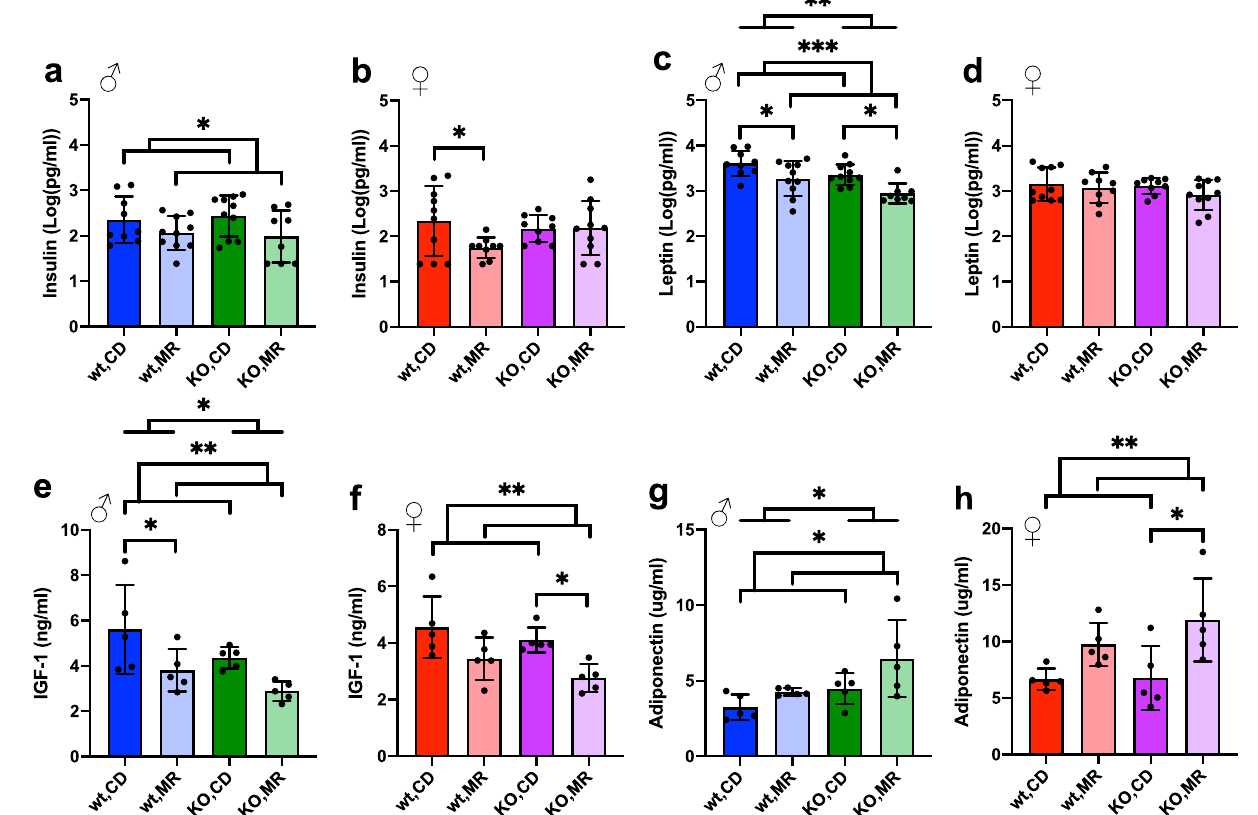
Figure 4. MR alters metabolic markers more in males. MilliPlex of serum from mice overnight fasted at time of sacrifice. Selected panel results of Insulin ( a ), ( b ) and Leptin ( c ), ( d ) measured by MilliPlex. Data was log transformed before analysis to preserve normality. Data points at lower end of detection were included as lowest value given by the assay’s internal standard curve. IGF-1 ( e ), ( f ) and Adiponectin ( g ), ( h ) measured in plasma by ELISA. Analysis was within each sex via Two-Way ANOVA for main effects. Post-hoc analysis was performed with Sidac multiple comparisons correction to assess the diet effect within each genotype. Graphs represent means ± s.d. and all groups were 8–10 mice for MilliPlex, and 5 mice per group for IGF-1 ELISA. (* p < 0.05; ** p < 0.01; *** p <